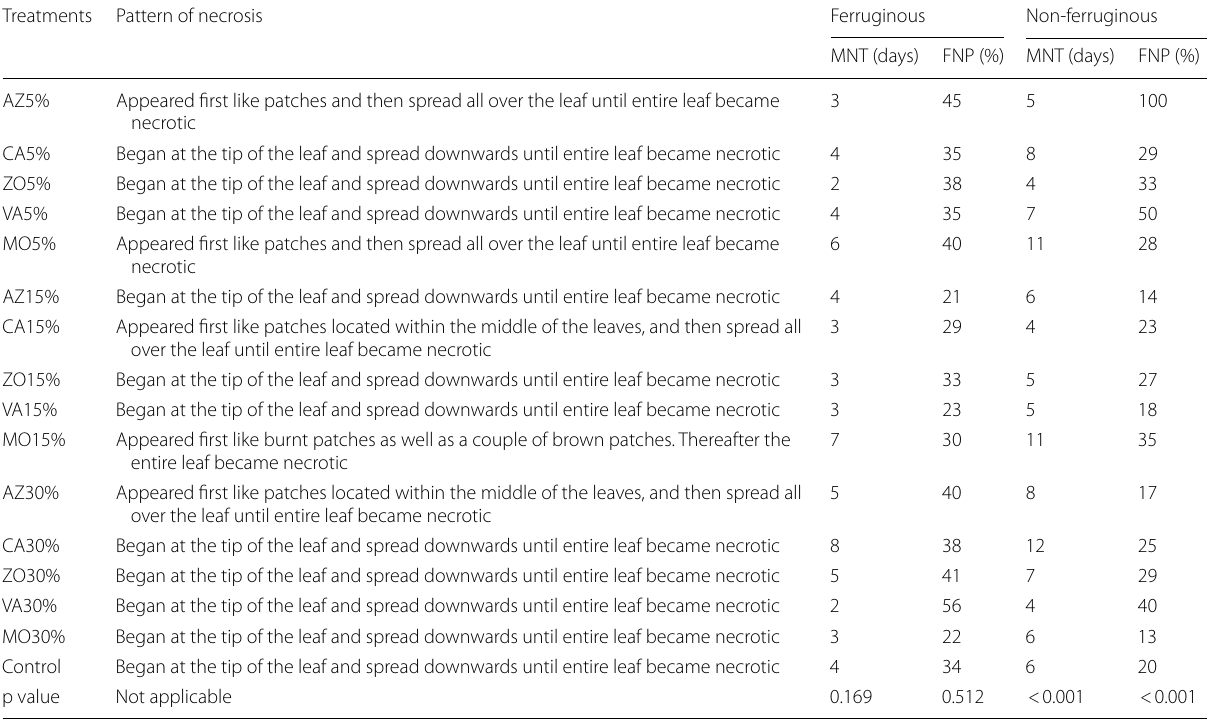
MNT Modal necrosis time, FNP Foliar necrosis percent, CA Carica papaya , VA Vernonia amygdalina , MO Moringa oleiofera , AZ Azadiracta indica ZO Hibiscus sabderiffa